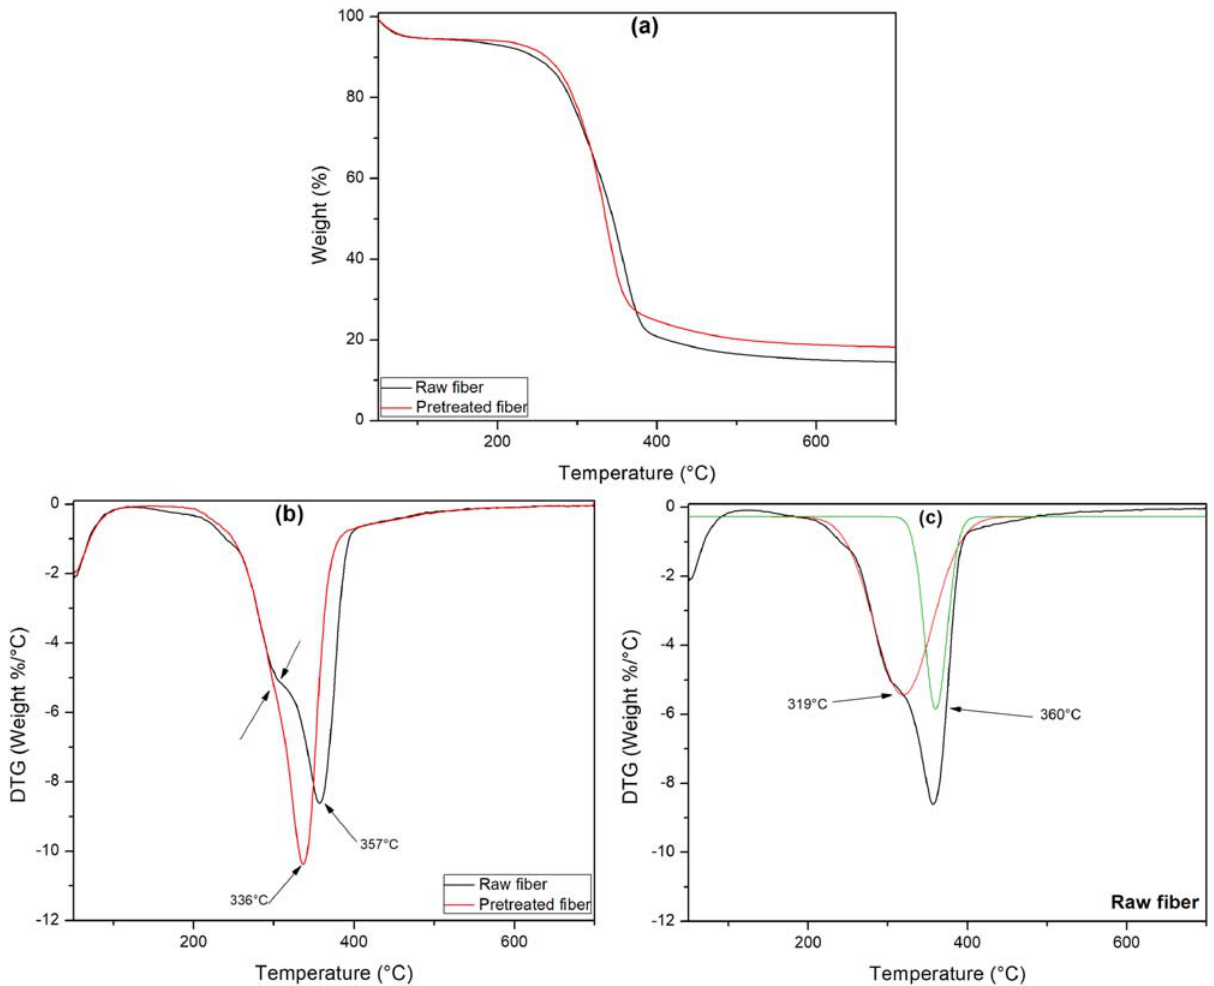
Figure 4: ( a ) TGA, ( b ) DTG of raw and pretreated fi bers and ( c ) deconvolution of DTG curves of raw fi ber.